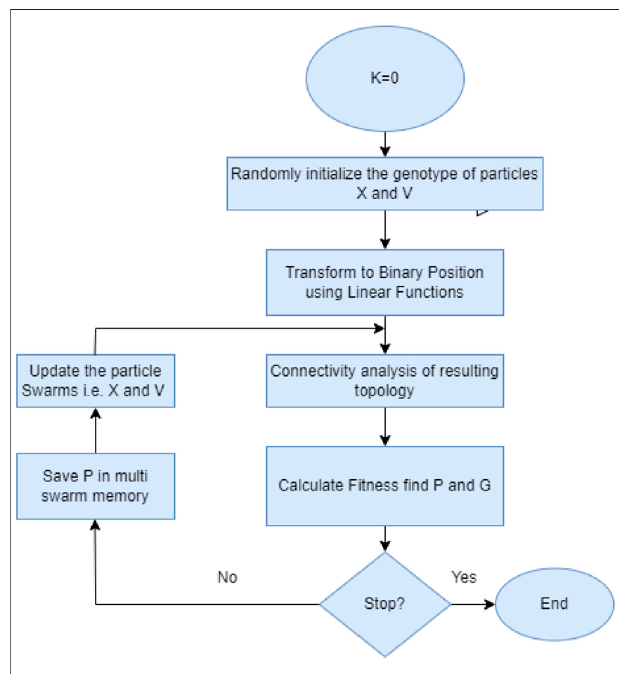
FIGURE 1 | Basic proposed architecture ofparticle swarm